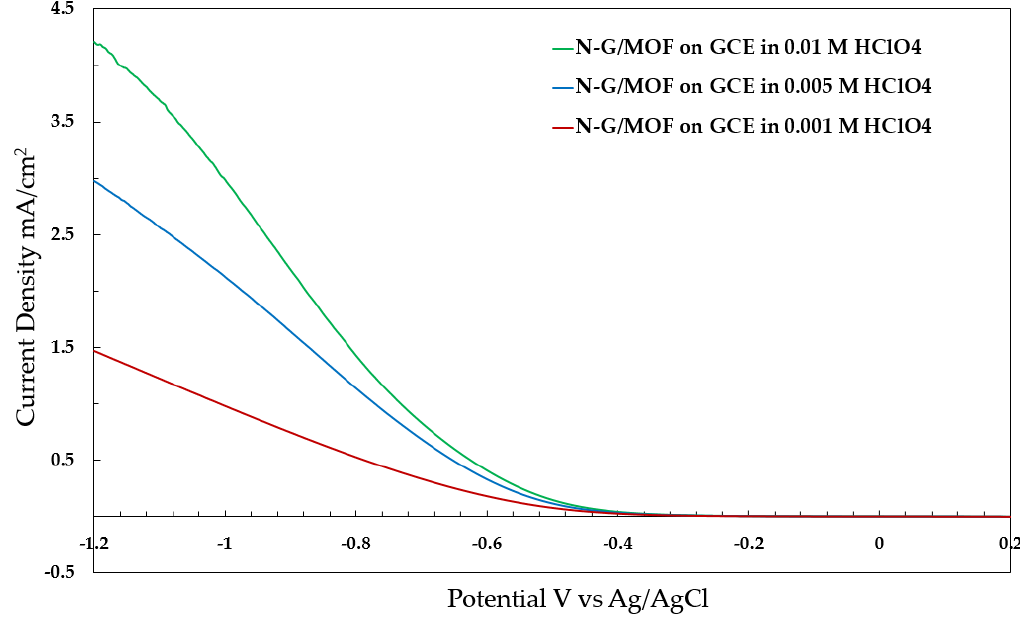
Figure 5. LSV plot for ORR in the 0.01 M HClO 4 (green line), 0.005 M HClO 4 (blue line), and 0.001 M HClO 4 (red lines) electrolyte on the N-G/MOF coated GCE working electrode.